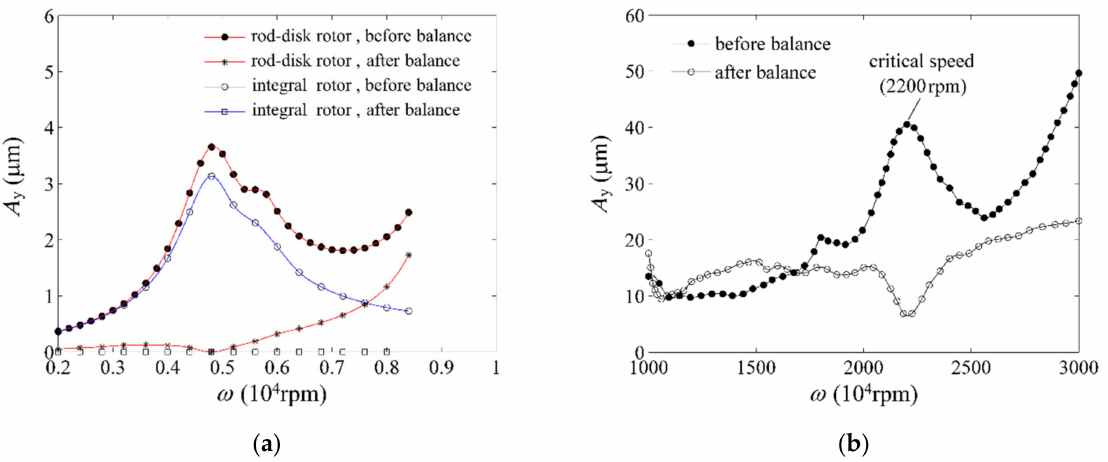
Figure 9. Wide–range vibration for both rod–disk rotor and gas turbine. ( a ) Rod–disk rotor; ( b ) Gas turbine